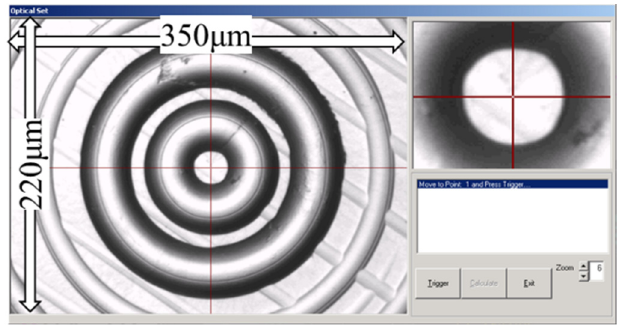
Figure 2. This is a microscope FOV.